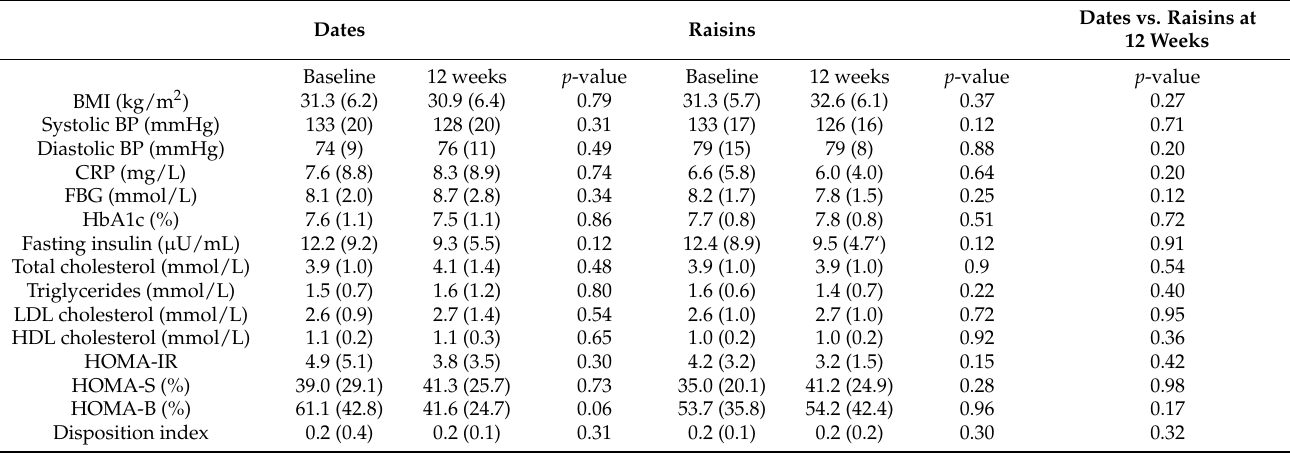
Table 2. Demographic and biochemical data both within group and between groups for the date fruit (n = 33 completed) and raisins (n = 28 completed) cohorts after 12 weeks of intervention. Data presented at mean +/ −